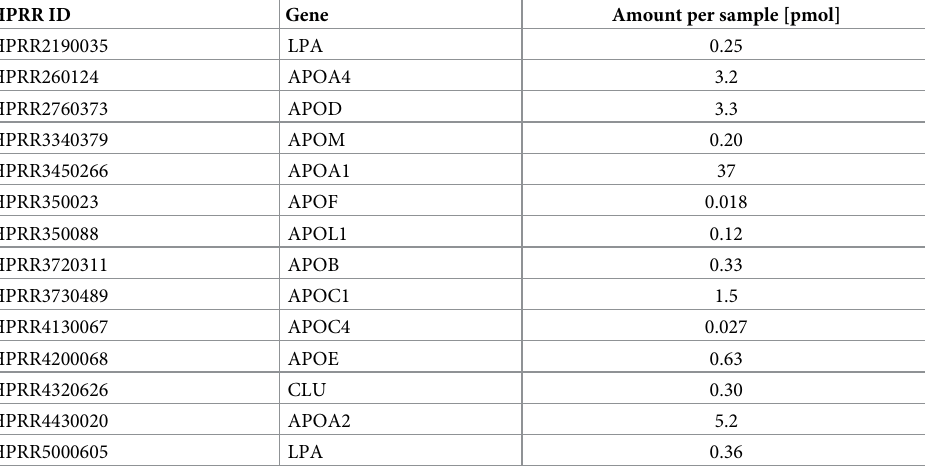
S3 Table. The LC was coupled to a TSQ Altis (Thermo Fischer Scientific) operating with a cycle time of 0.5 seconds monitoring the transitions specified in S4 Table. Table 1. Composition of standard pool used for quantification of apolipoproteins in sample